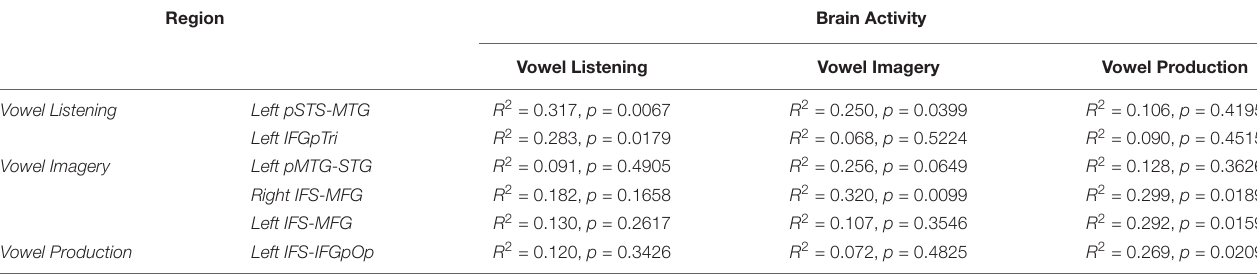
TABLE 4 | CCA results in regions from vowel listening, imagery and perception (lines), between brain activity in each task (columns) and the articulatory model. Region